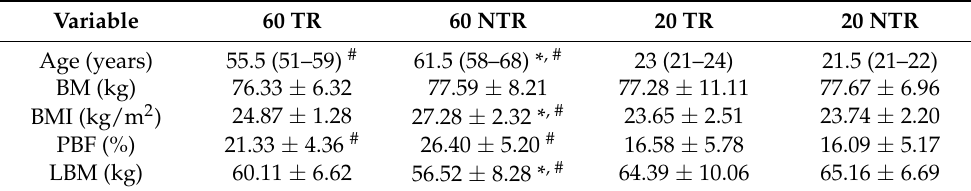
Table 2. Age and somatic characteristic of the participants.